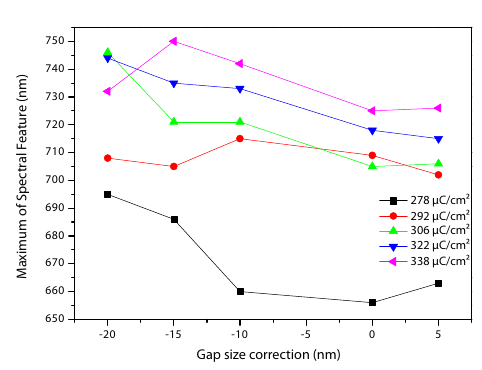
Figure 12: Maximum of the spectral response of all bow-tie arrays, grouped by e − -beam dose, smallest to highest. The decreasing resonance wavelengths for larger gap size corrections is a clear trend, implying that in almost all gap size scenarios, the triangles do not form a coupled